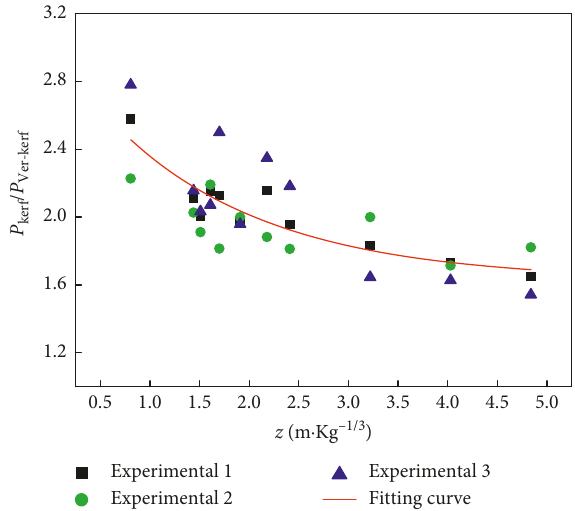
Figure 9: Pressure attenuation curve of the cutting direction and the vertical direction of the cutting seam cartridge.